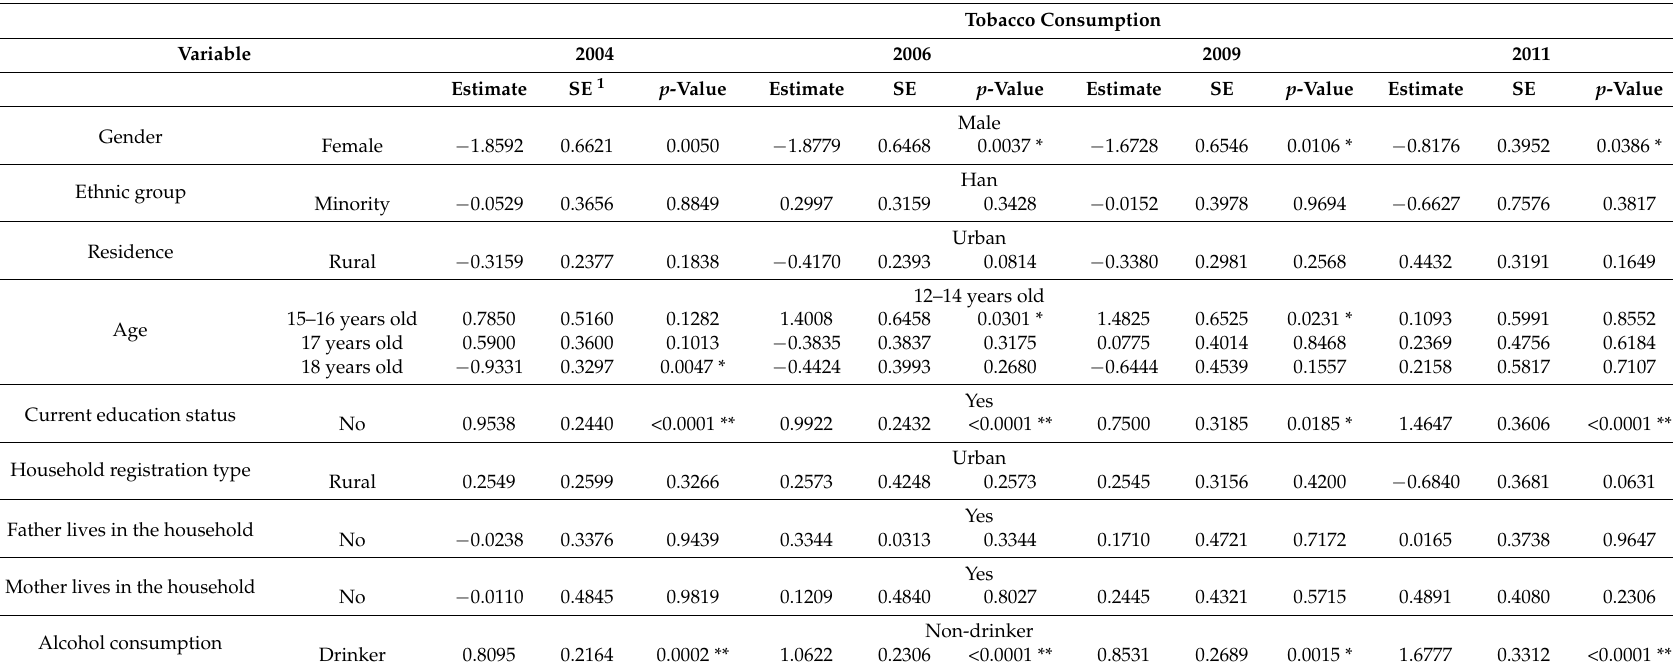
Table 3. Penalized logistic regression analysis for tobacco consumption among Chinese adolescents (from 12–18 years old),